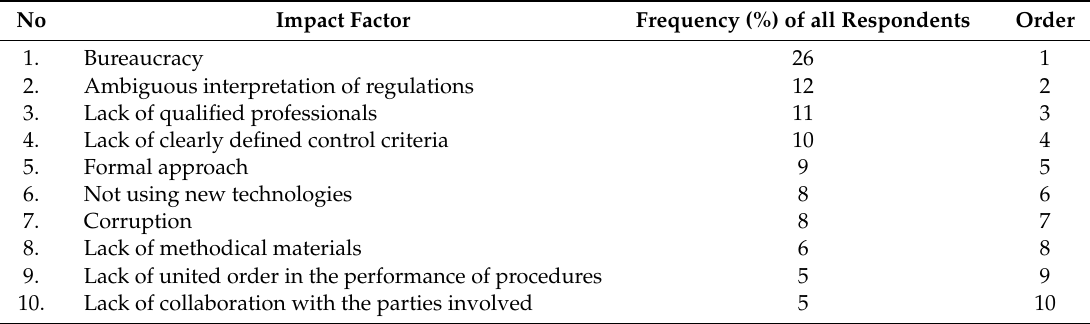
Table 2. The most frequent impact factors influencing negatively the achievement of sustainability in the supervision process.